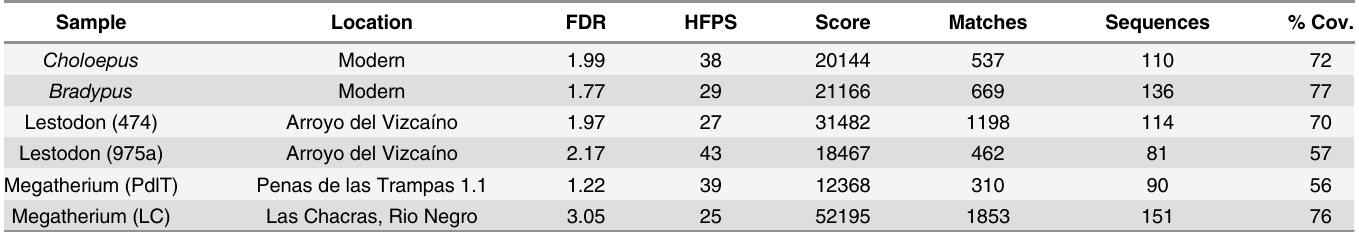
Table 2. Proteomics information relating to the quality of the Mascot search results, including the False Decoy Rate (FDR), highest scoring false positive peptide (HFPS), the total protein score for sloth collagen, the number of peptide matches used for this score, the number of unique sequences and the percentage coverage.